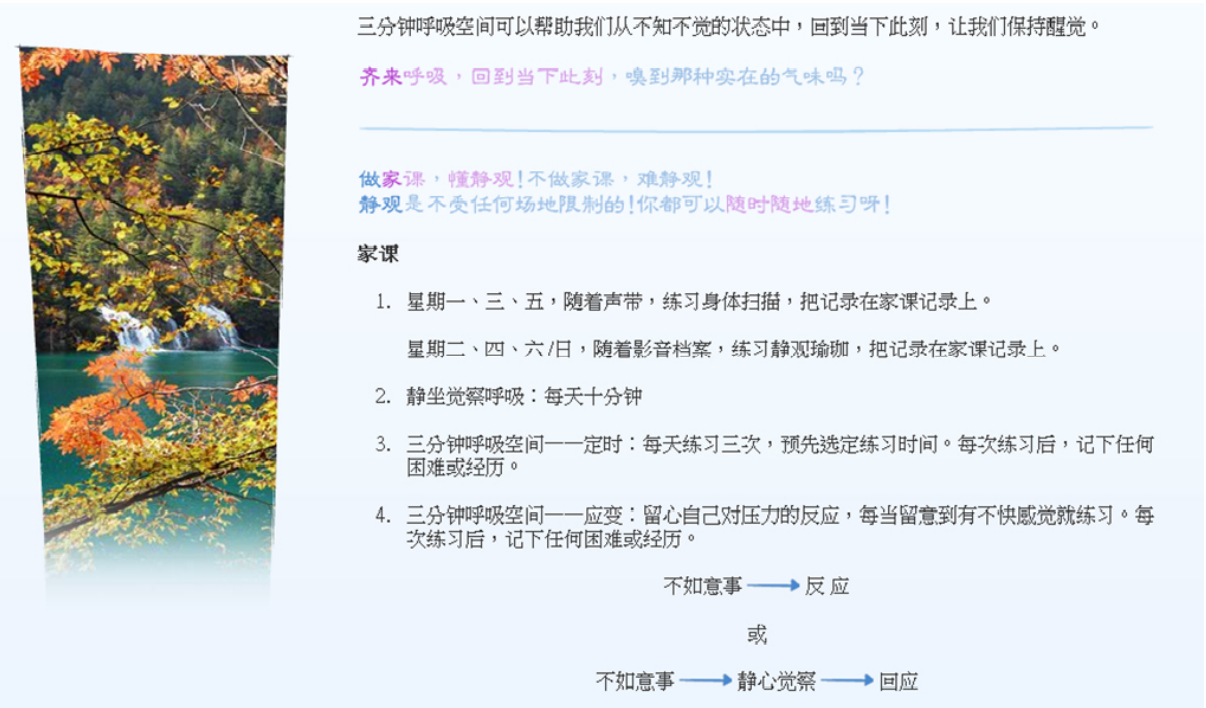
Figure 4. Suggested off-class mindfulness